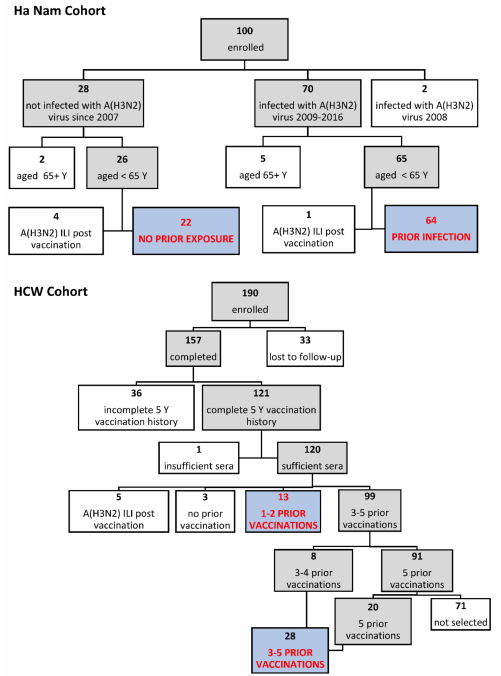
Figure 1. Participant inclusion and exclusion criteria. Shaded boxes indicate participants that met each of the inclusion criteria considered; clear boxes indicate those that were excluded. Blue shaded boxes indicate the four groups analyzed in this